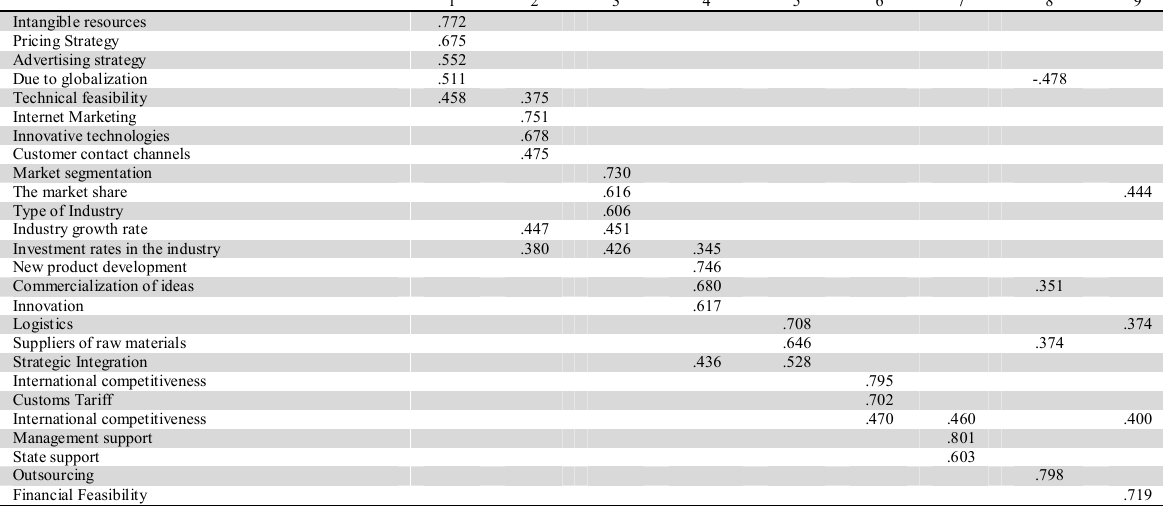
The summary of factor analysis after rotation has